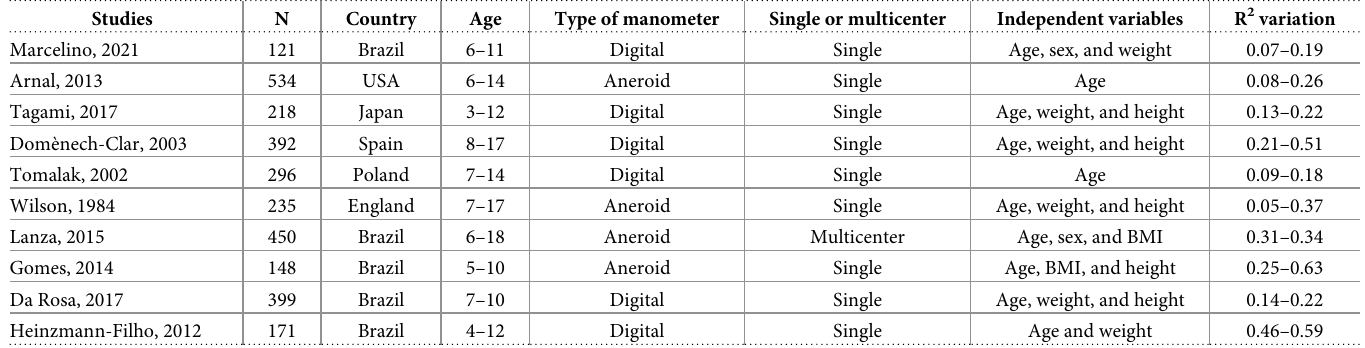
Table 4. Methodological characteristics of previous studies.